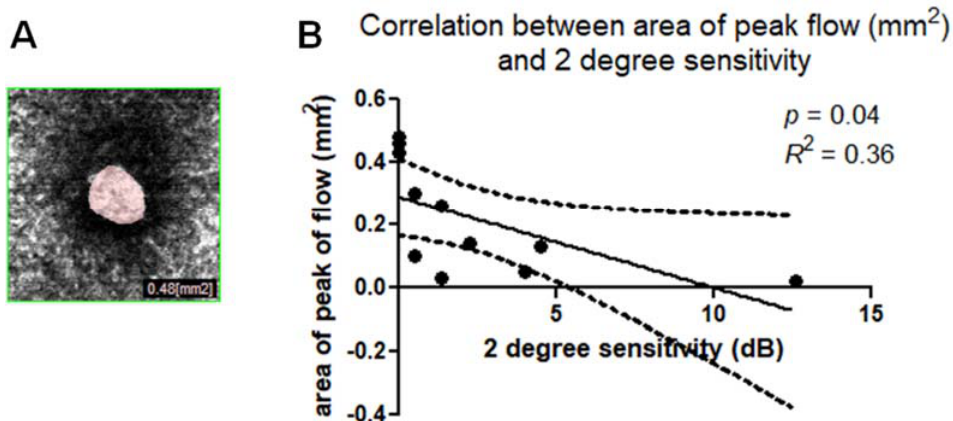
Figure 8. ( A ) Area of peak of flow in the choroidal slab (also named “choriocapillary transparency”) due to visibility of choroidal vessels caused by lack of neuroepithelium. ( B ) Scatterplot shows the statistically significant correlation ( p = 0.04, R 2 = 0.36) between the area of peak of flow in the choroidal slab (mm 2 ) and microperimetry 2 degree sensitivity (DB).